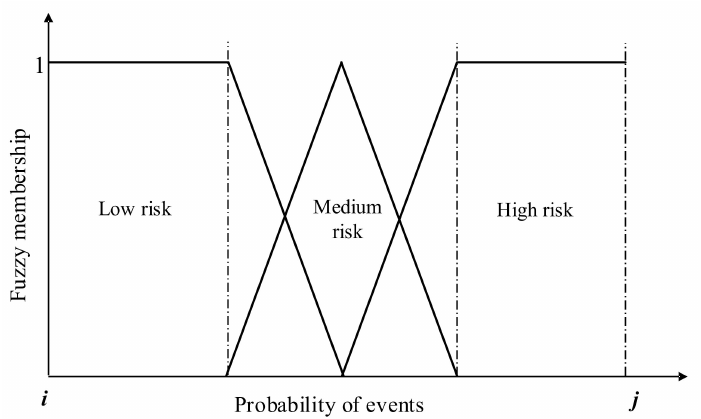
Figure 2. Mapping between the fuzzy membership and probability of the